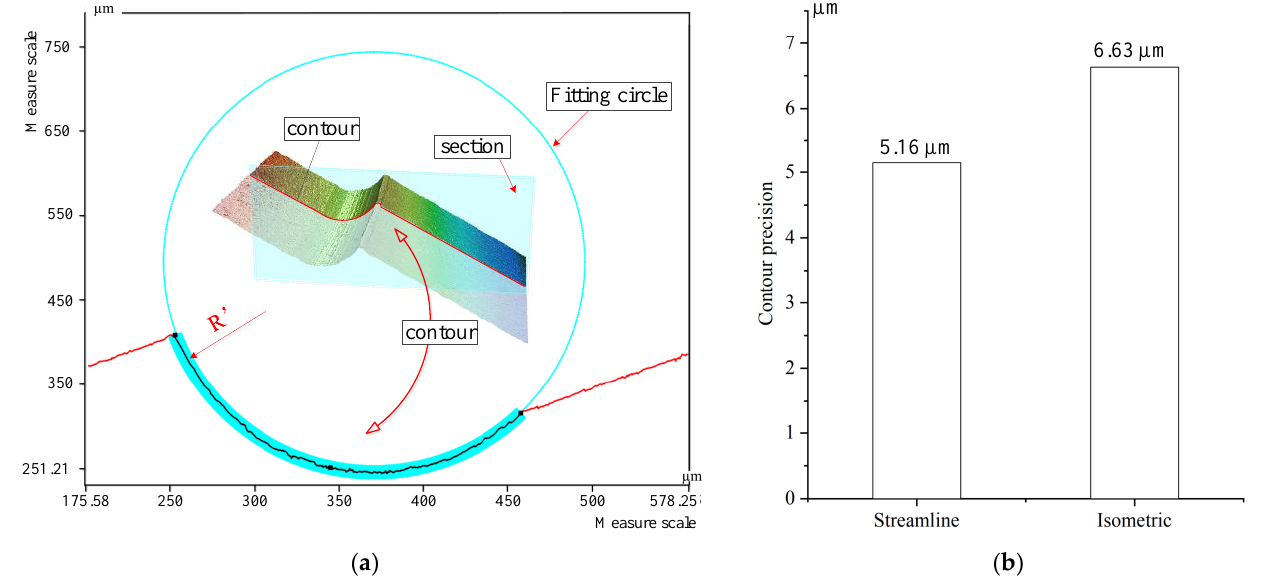
Figure 15. ( a ) Contour accuracy measurement. ( b ) Contour accuracy result.